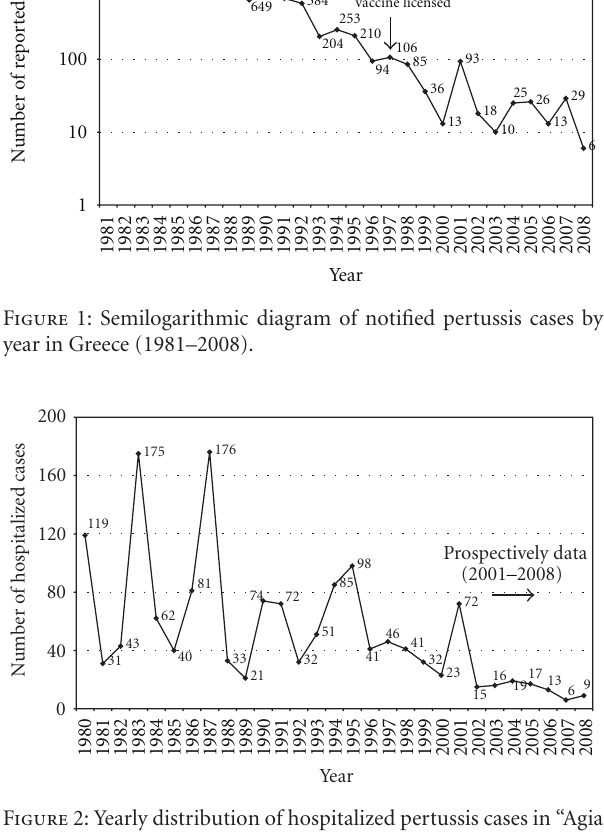
Figure 2: Yearly distribution of hospitalized pertussis cases in “Agia Sofia” Children’s Hospital, Athens, Greece, 1980–2008.